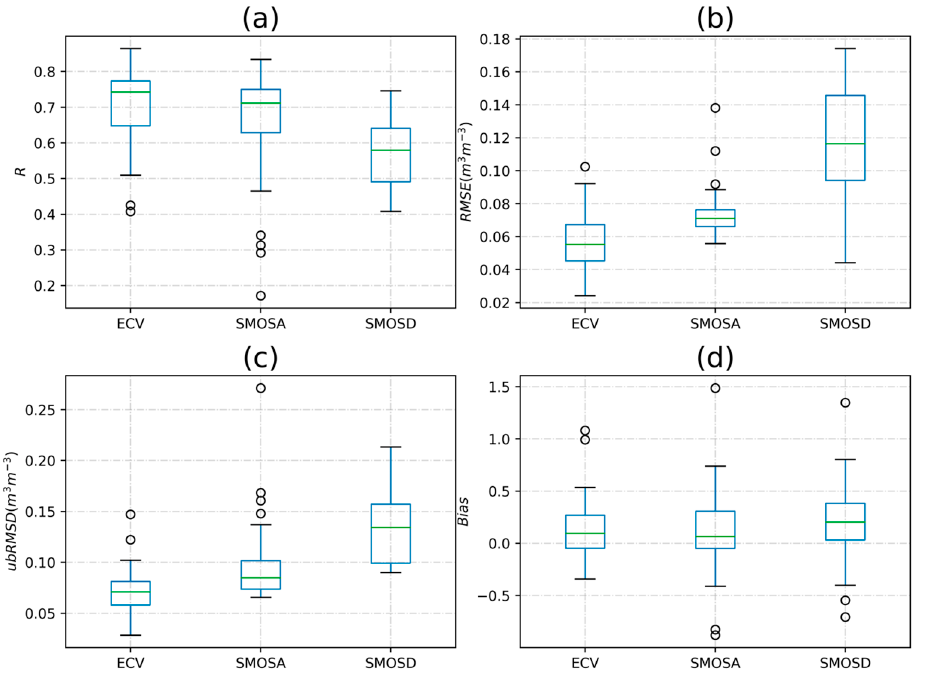
Figure 3. The box plots showing the error metrics of each sites in the three networks: ( a ) R, ( b ) RMSE, ( c ) ubRMSD, and ( d ) Bias.